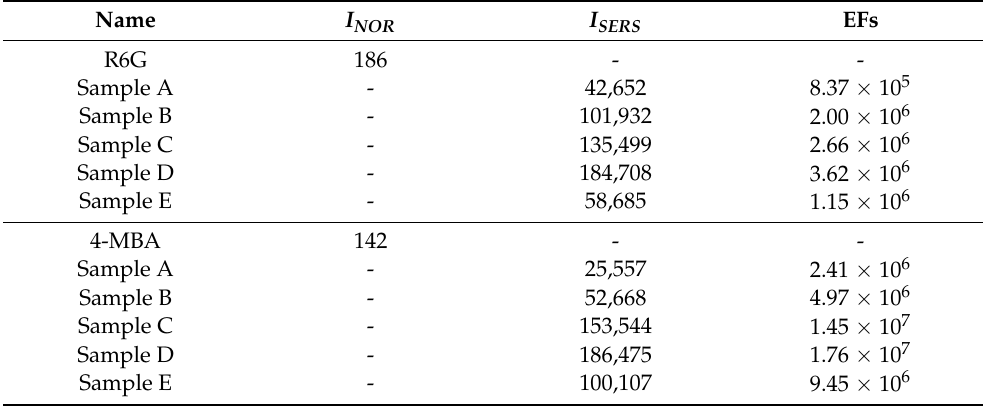
Table 1. SERS enhancement factors of the samples